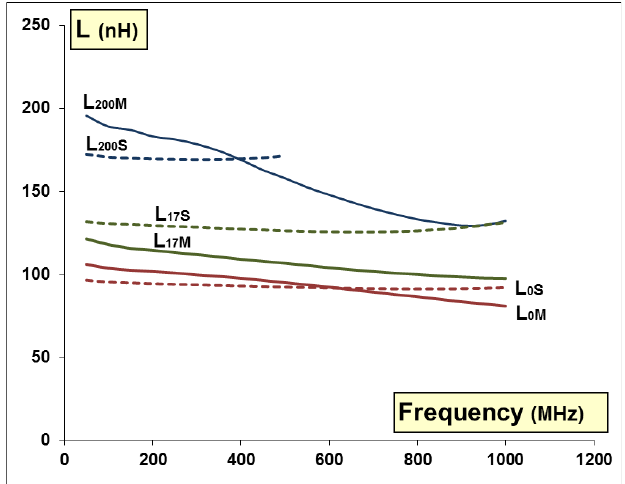
Figure 10: Measured (M) and simulated (S) inductance of the micro-inductor versus frequency for different thicknesses of the magnetic material (0 µm, 17 µm and 200 µm) By comparing results obtained for thin and thick magnetic layers with the inductance without magnetic material (fig. 10), we noticed that by using the micro-machined thick layer permits to double the value of the inductance as shown in figure 9. However, for thin magnetic films a ratio of 1.14 is obtained. The YIG magnetic permeability decreases with the frequency